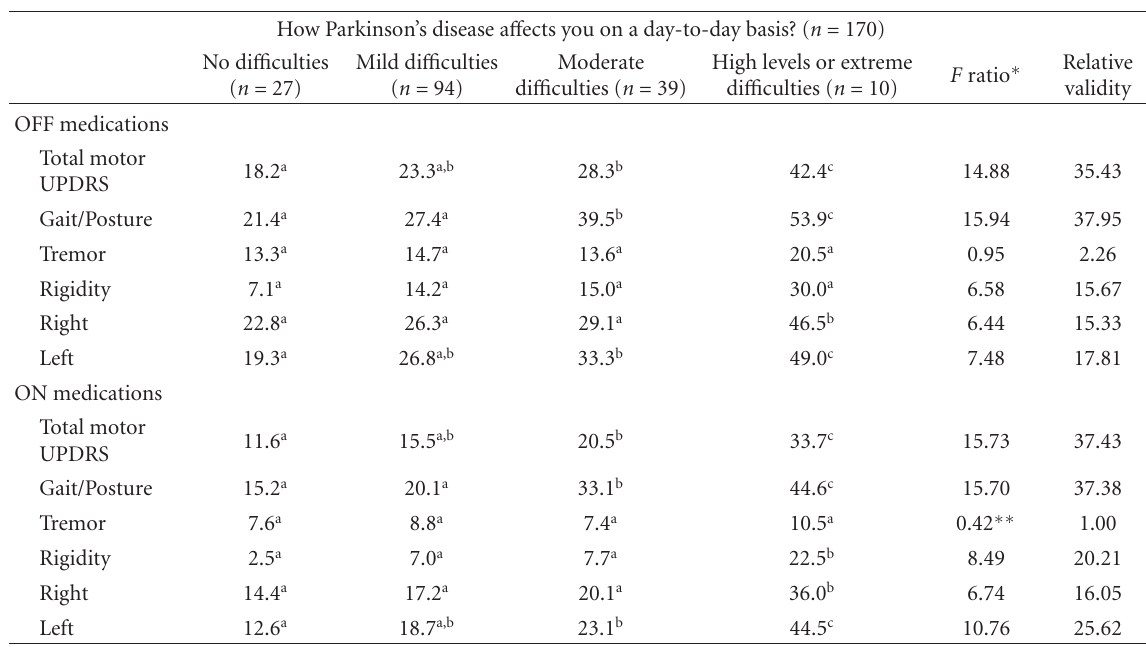
Table 5: (a) Relative validity of total motor UPDRS and subscales by how PD a ff ects on day-to-day basis ratings ∗ , (b) Relative validity of total motor UPDRS and subscales by PD symptoms severity ( n =